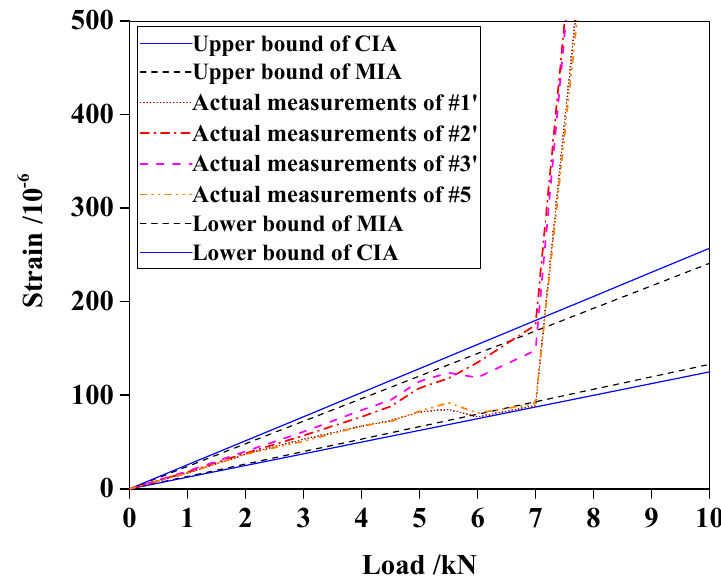
Figure 6. Strain interval envelopes of the experimental beam.